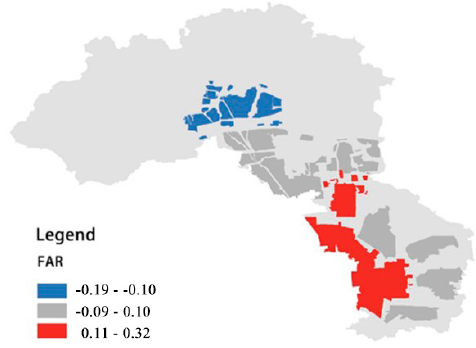
Figure 5. Grivation results of Scenario 1.